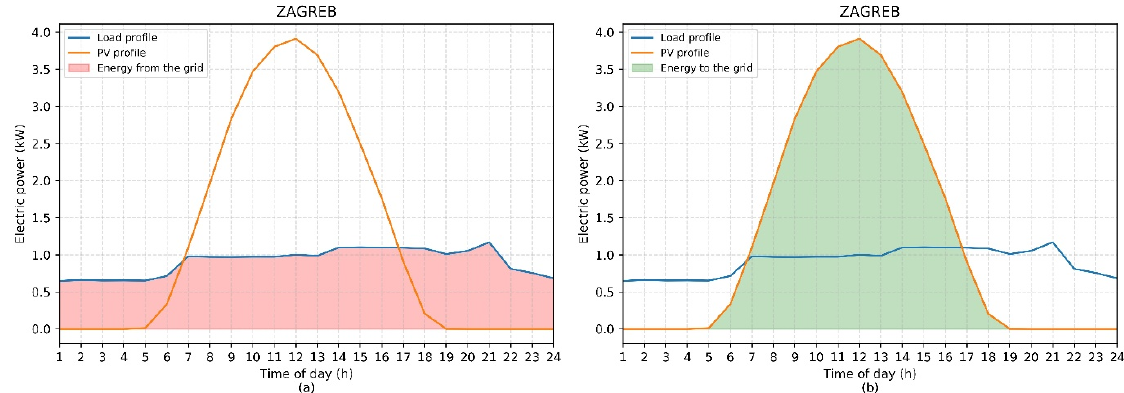
Figure 3. Electrical energy balance between household and power grid according to the FiT model. ( a ) Electricity from the grid. ( b ) Electricity to the grid.